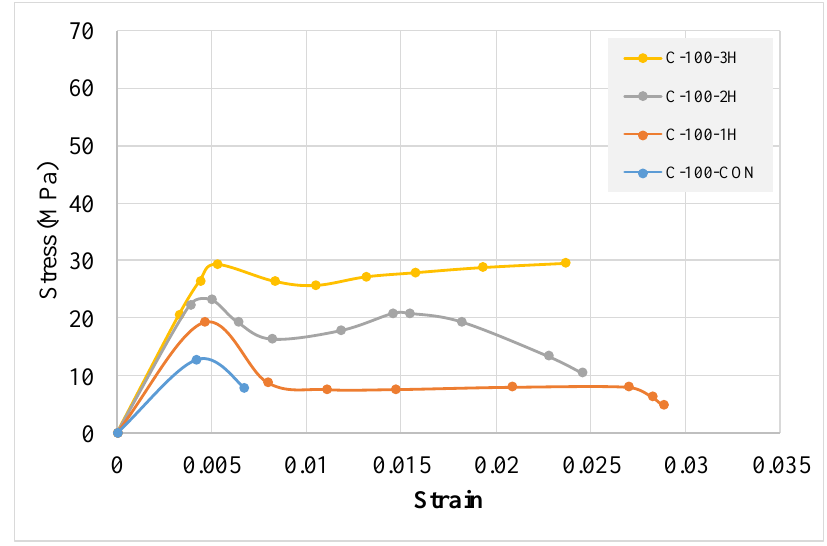
Figure 11. Compressive stress versus strain response of Group 3 cylinders.